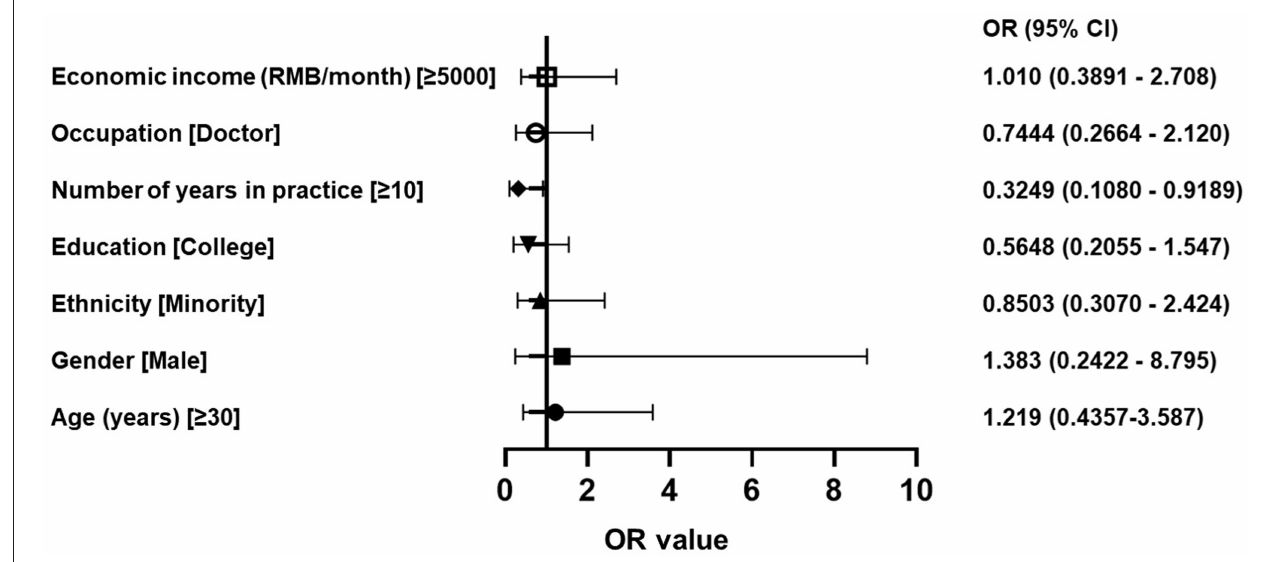
FIGURE 2 | Forest plot of logistic regression.